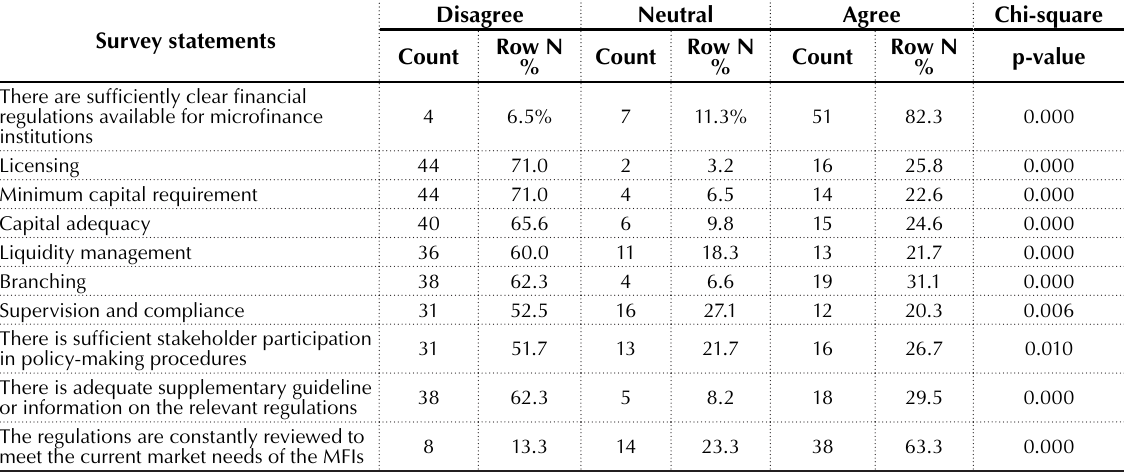
Table 4. Regulations and their formulation